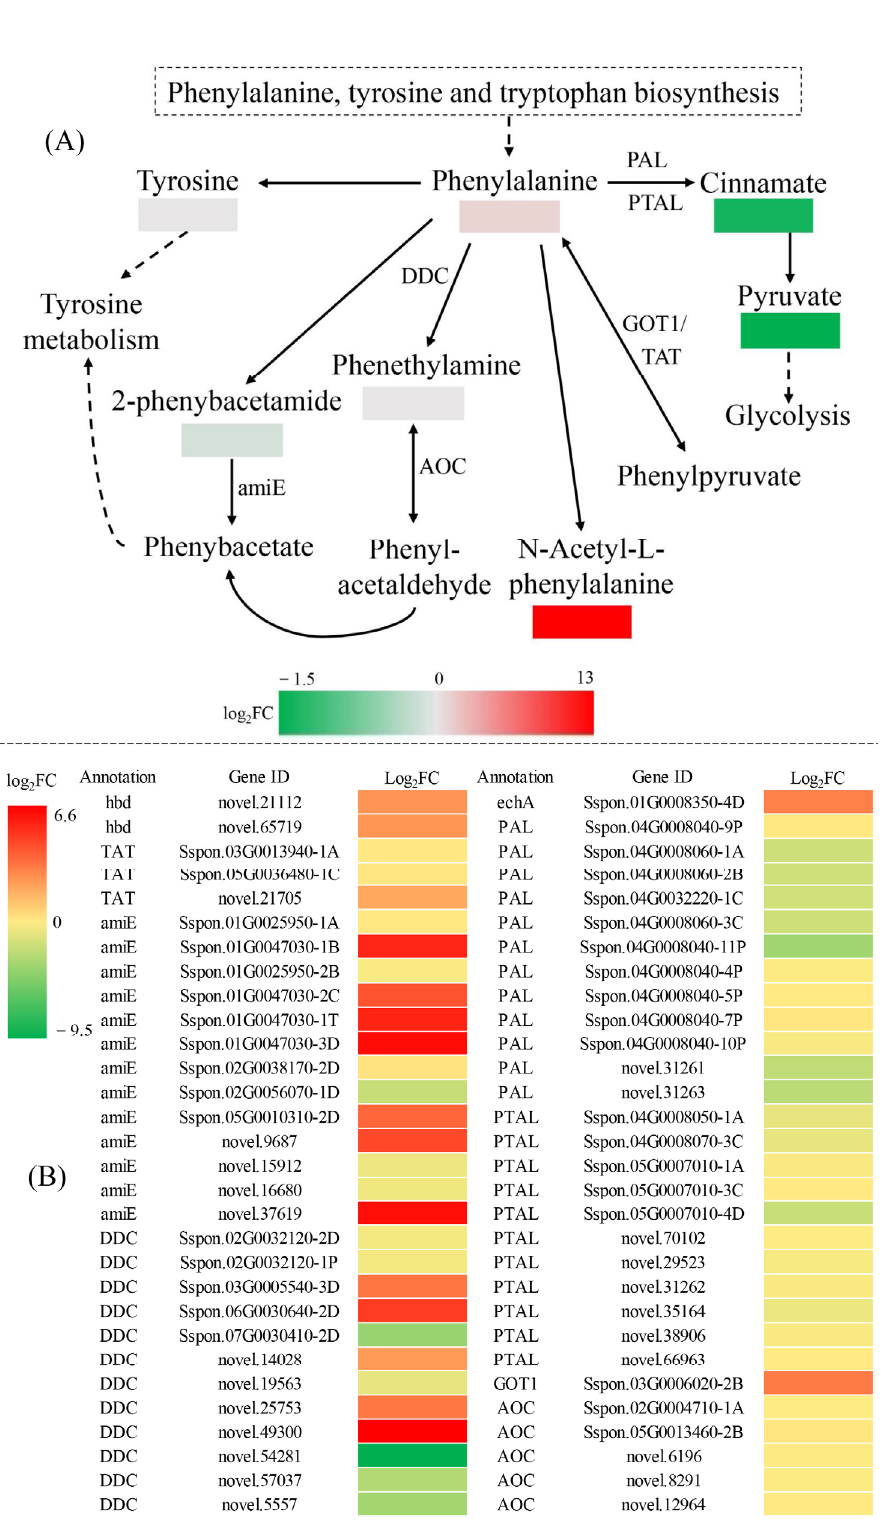
Figure 8. Analysis of DEGs and SRMs in the phenylalanine metabolism pathway. Enriched ( A ) SRMs and ( B ) DEGs color-coded according to fold-change between CG and DS groups. |log 2 FC| denotes |log 2 Fold Change|. Solid line stands for direct reaction. Dashed line stands for indirect reaction, which means it have to go through multiple reactions.